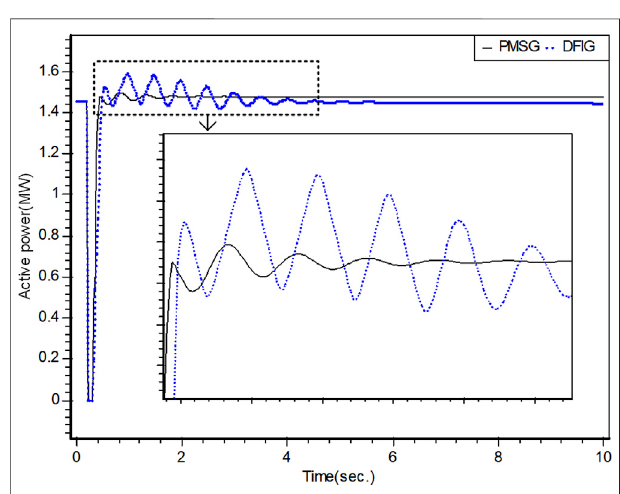
FIGURE 8 | Active power of DFIG and PMSG.